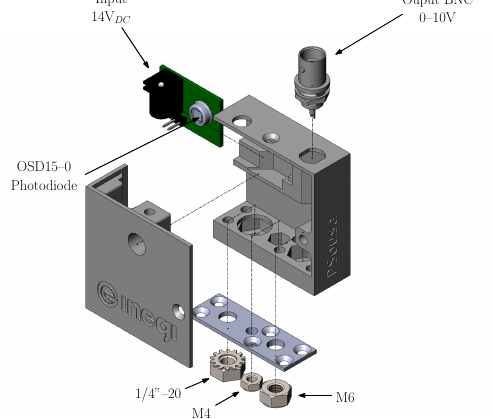
Figure 8. Main components and features of the developed OSD15–0-based photodetector